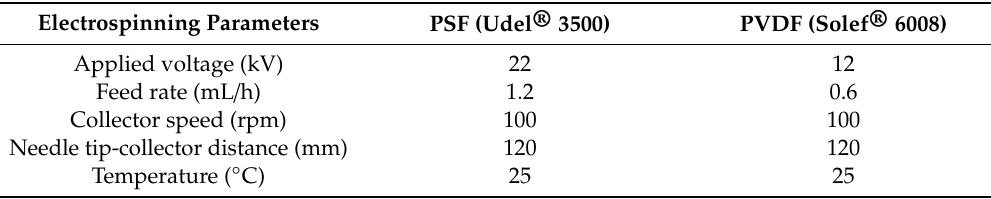
Table 2. Electrospinning parameters.